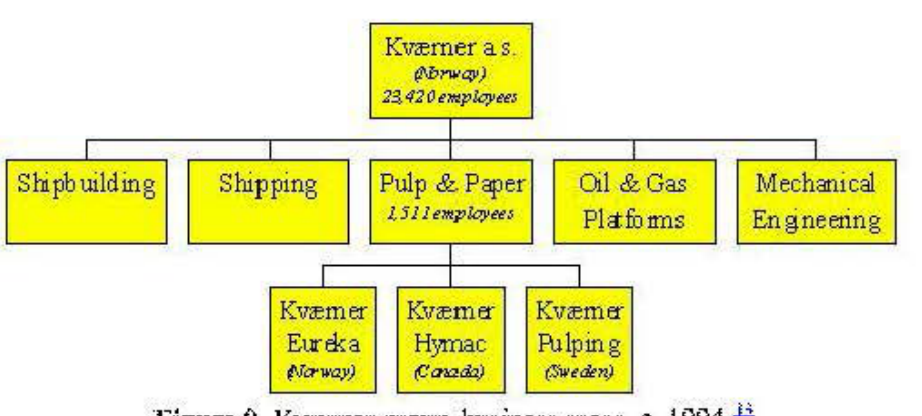
Figure 9. K,..-rerncrgmup business areas. c.